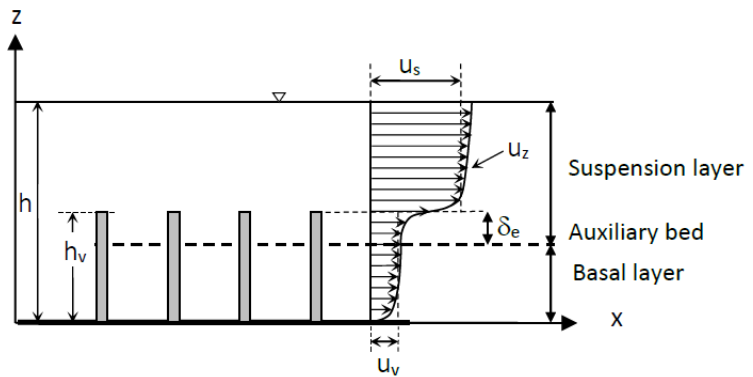
Figure 6. Side view of submerged vegetation with auxiliary bed and velocity profile.